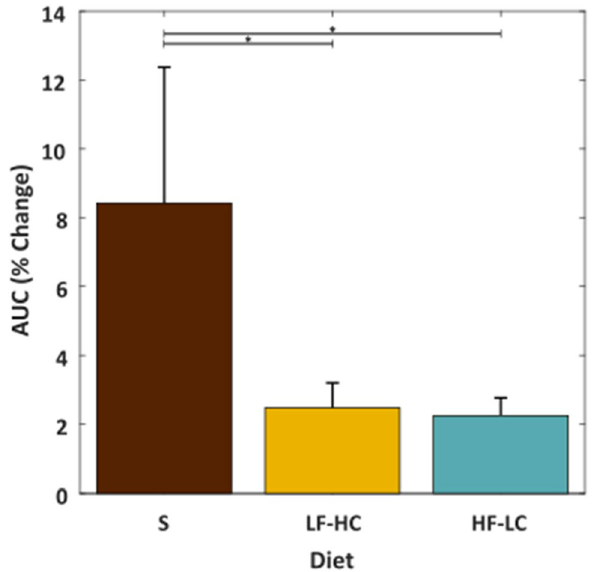
Figure 5. The change observed in the area under the curve (AUC) within vagal nerve recordings across animals, time samples, and MEA channels during large stomach distensions. Diet types are standard (S), low fat high carbohydrate (LF-HC), and high fat low carbohydrate (HF-LC). Significant differences (p ≤ 0.05) are denoted with